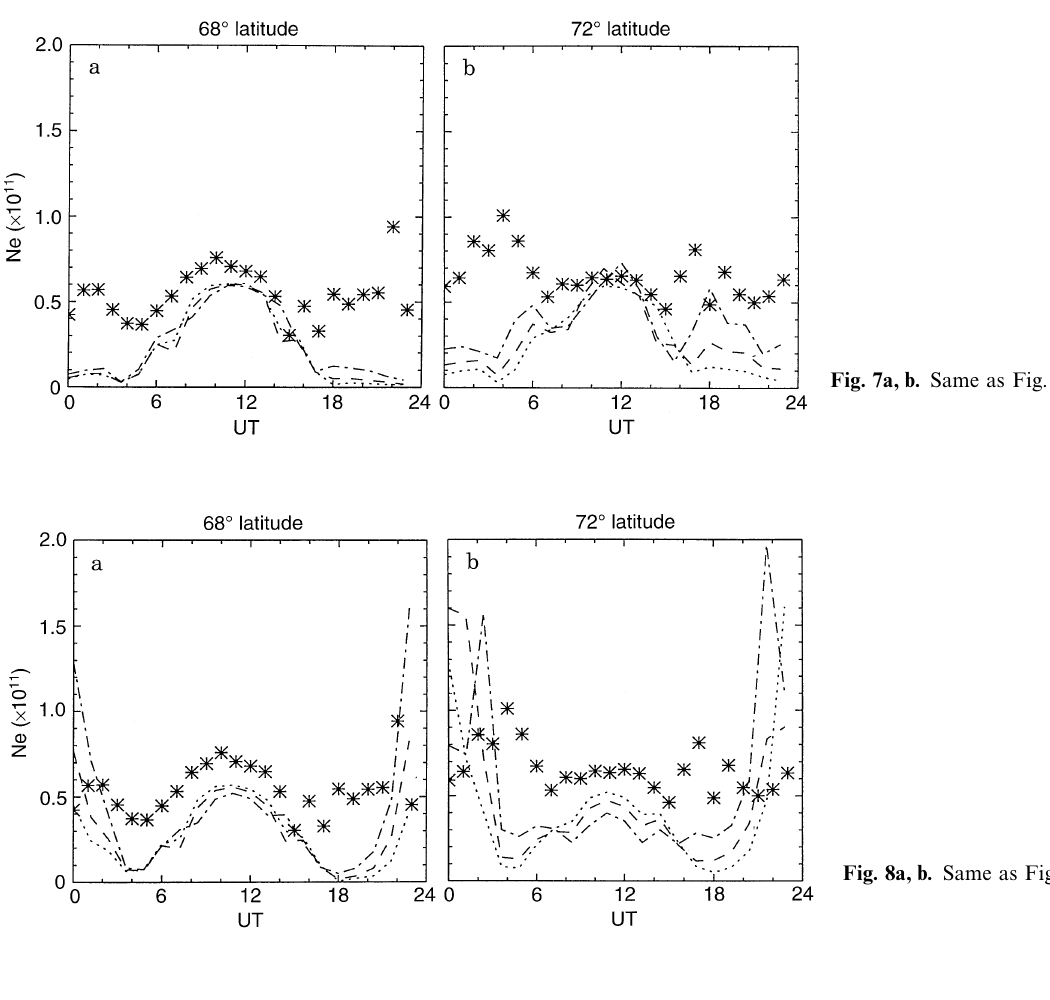
Fig. 8a, b. Same as Fig. 4 but for RUN-3